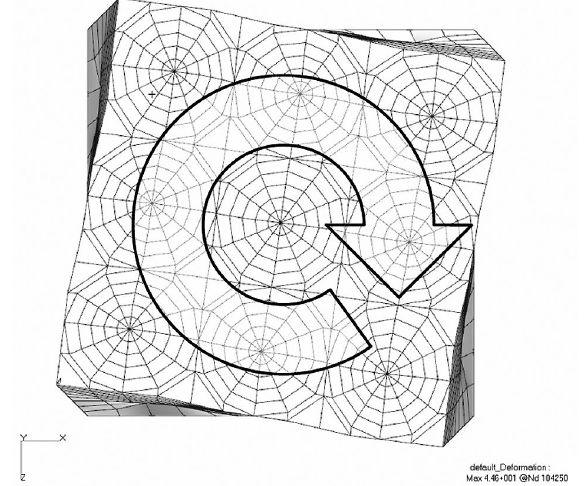
Fig. 27. 3rd mode: − 796 Hz Y Symmetric uniform rotation (781 Hz – Quad-cell).